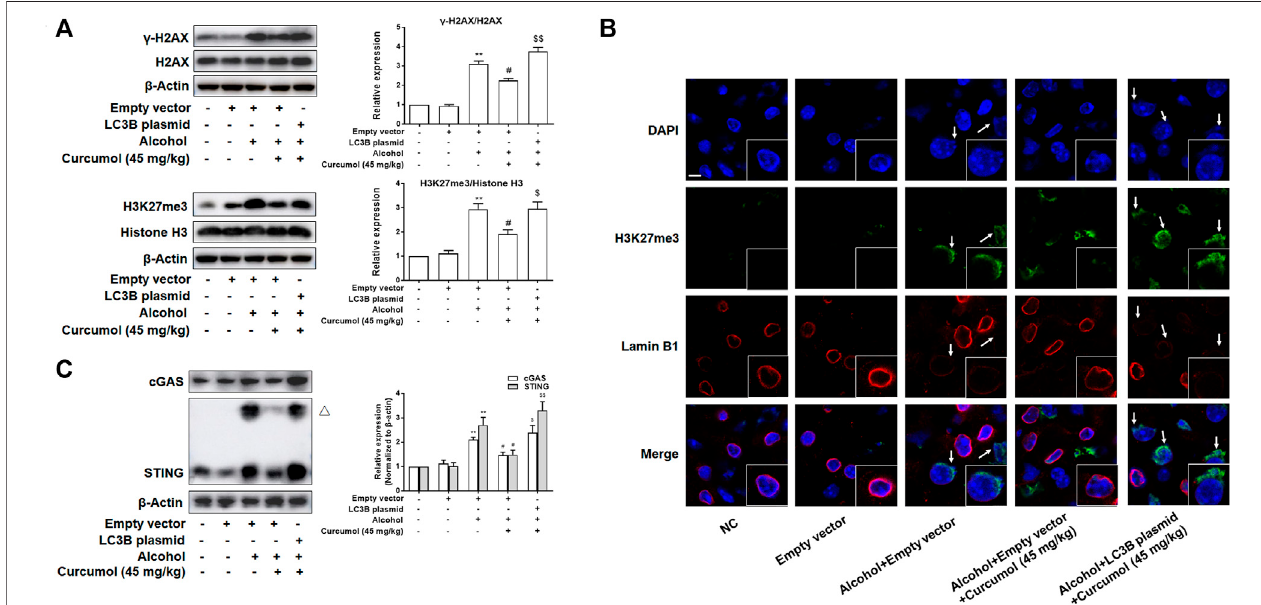
FIGURE8| Curcumol ’ srepressionoftheinteractionofLC3B-laminB1,whichinhibitedtheformationofCCFandtheactivationofcGAS-STINGintheliverofAFLD. (A) Western blot analyses of the classical markers of CCF ( γ -H2AX and H3K27me3) protein levels in the liver tissues, n = 3. Data are represented as mean ± SD. Signi fi cance: ** p < 0.01 versus empty vector group, # p < 0.05 versus empty vector +alcoholgroup, $ p < 0.05 and $$ p < 0.01 versus empty vector + alcohol + curcumol group. (B) Immuno fl uorescence staining analyses of the production of CCF by detecting the expressions of lamin B1 and H3K27me3. CCF (green) and the loss of Lamin B1 (red) are indicated by arrows. n = 3. Sacle bar, 7.5 μ m. (C) Western blot analyses ofthe expression of cGAS and STING in the liver tissues, n = 3. STING blots were performed under non-reducing conditions. △ STING dimer. Data are represented as mean ± SD. Signi fi cance: ** p < 0.01 versus empty vector group, # p < 0.05 versus empty vector + alcohol group, $ p < 0.05 and $$ p < 0.01 versus empty vector + alcohol + curcumol